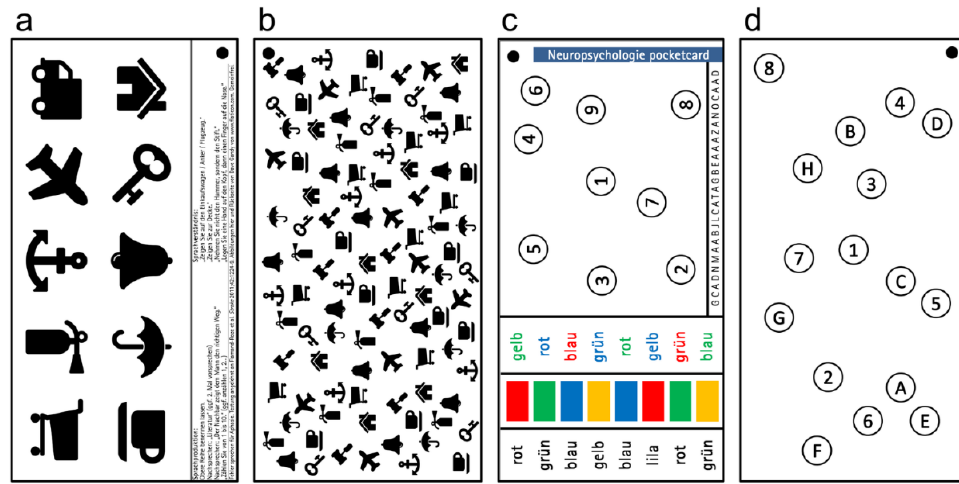
Figure 1. Neuropsychology pocketcard set. The four pages of the pocketcard set used in this study, including tests for aphasia ( a ), neglect ( b ) and executive functions ( c , d ). Page 1 (Figure 1a) is used for aphasia screening and consists of 10 black-and-white